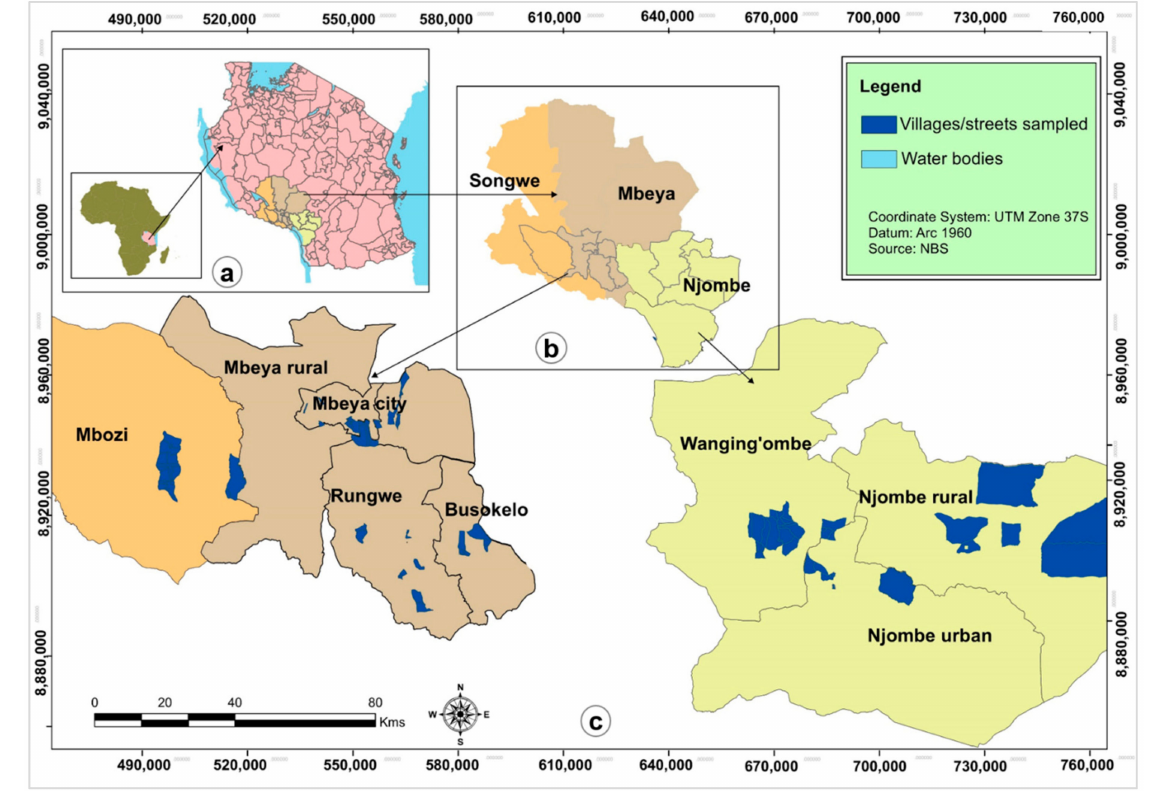
Figure 1. Study site map: ( a ) Top left is Tanzania’s location in Africa (small scale map) and the three avocado rich regions’ locations (large scale map); ( b ) Top center is the three regions showing the districts included in this research; ( c ) Bottom are the village/street locations in the districts. Table 1. Sampling